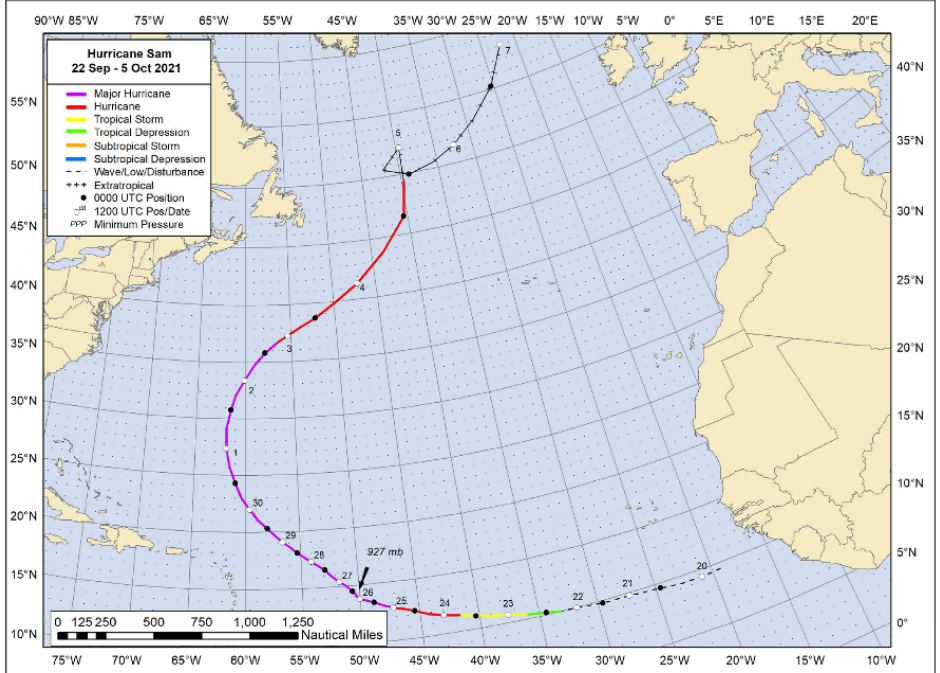
Figure 1. Best track positions for Hurricane Sam, 22 September–5 October 2021. Tracking during the extratropical stage is partially based on analyses from the NOAA Ocean Prediction Center.